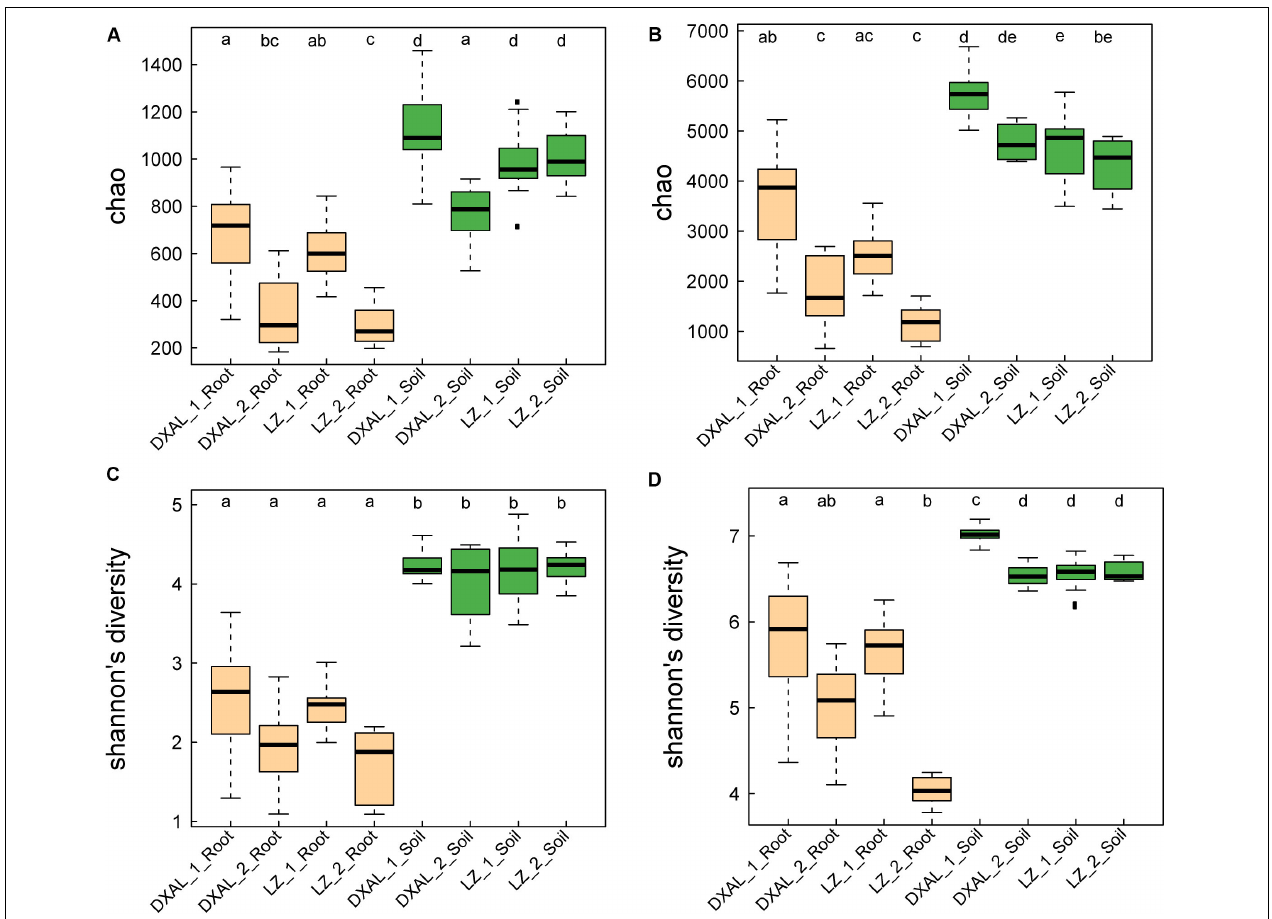
FIGURE 1 | Species richness and diversity of root-associated microbial communities. (A) Microbial richness index comparison between each group based on the Chao index using the ITS data. (B) Microbial diversity index comparison between each group based on the Shannon index using the ITS data. (C) Microbial richness index comparison between each group based on the Chao index using the 16S rRNA gene data. (D) Microbial diversity index comparison between each group based on the Shannon index using the 16S rRNA gene data. Significant differences are depicted with letters ( P < 0.05, Kruskal–Wallis with Dunn’s post hoc test). DXAL: Greater Khingan Mountains, LZ: Linzhi, 1: vegetative growth stage, 2: reproductive growth